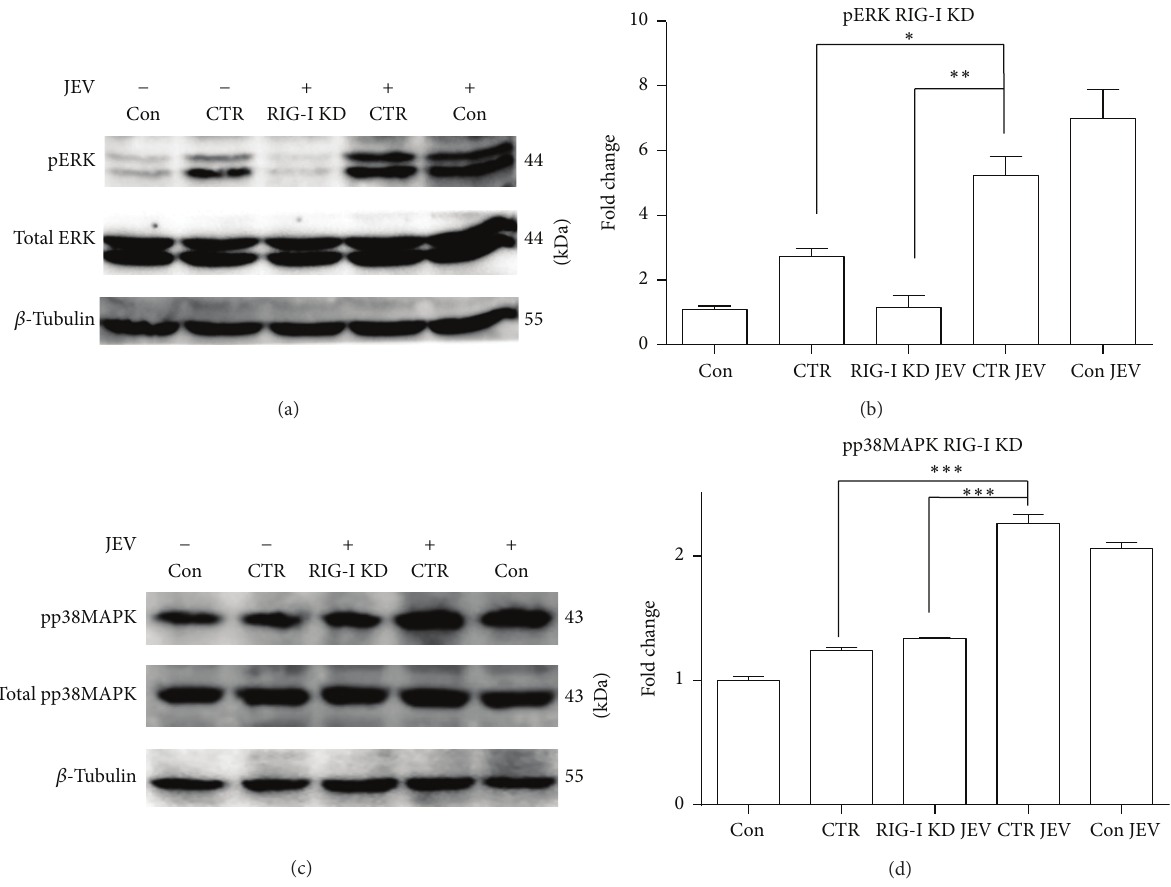
Figure 5: Knockdown of RIG-I attenuates the activation of p38MAPK and ERK in JEV-infected BV-2 cells. BV-2 cells were transfected with RIG-I shRNA (RIG-I KD) or negative control shRNA (CTR) and then infected with JEV at an MOI of 1. (a, c) Phospho-ERK (pERK) and phospho-p38MAPK (pp38MAPK) were detected with western blotting at 5hpi. (b, d) The protein levels were quantified with immunoblot scanning and normalized to the amount of 𝛽 -tubulin. Error bars represent the standard deviation of results from three independent assays ( ∗ 𝑃 < 0.05 ; ∗∗ 𝑃 < 0.01 ; ∗∗∗ 𝑃 < 0.001